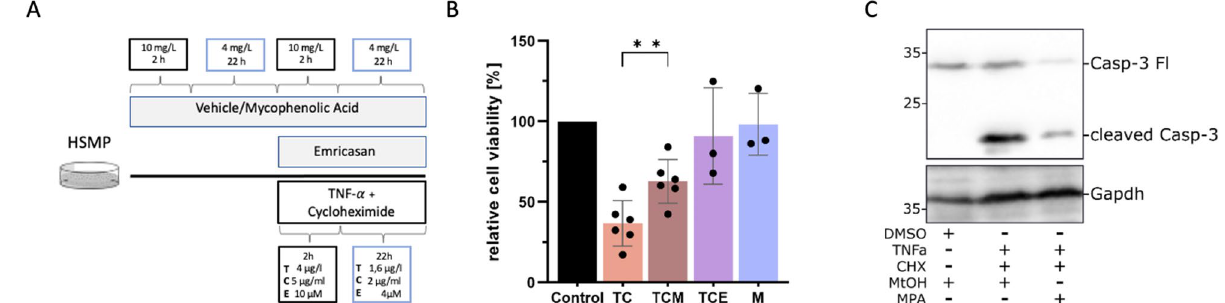
Figure 3. MPA increases cell viability during TNF-α and CHX induced cell death. ( A ) Cells were treated with either Vehicle or MPA (M) for 48 h, or Emricasan (E) for 24 h. All cells received Tumor Necrosis Factor-α (T) and Cycloheximide (C) for 24 h. An additional control group received only MPA for 48 h (M). This resulted in 5 treatment groups (Control, TC, TCM, TCE and M), which were analyzed with a cell viability assay. ( B ) Quantification of cell viability after treatment with combinations of Tumor Necrosis Factor-α (TNF- α; T), Cycloheximide (CHX; C), Mycophenolic Acid (MPA; M) and Emricasan (E). Control cells received only vehicles. Cell viability of each sample was normalized against the control of their respective passage. TC-treatment resulted in a drastic decrease of cell viability. Additional MPA treatment significantly increases cell viability compared to TC only (36.8 vs. 62.9%). Emricasan was able to prevent cell death in a very high degree (91%). Treatment with only MPA showed no signs for proliferative activity of the drug. ** p < 0.01 ( C ) Western Blot Analysis of cleaved Caspase-3 levels. Lane 1, Control. Lane 2, TC. Lane 3, TCM. Treatment with TC results in a steep increase of cleaved Caspase-3 levels. TCM treated cells display a reduction of cleaved Caspase-3 compared to TC treated cells. Fl, full length. DMSO, Dimethyl sulfoxide. MtOH, Methanol. Gapdh, Glyceraldehyde 3-phosphate dehydrogenase. The displayed blot was cropped for better visualization. The boxes exemplify different regions of the same gel. The uncropped blots can be found as Supplementary Fig.